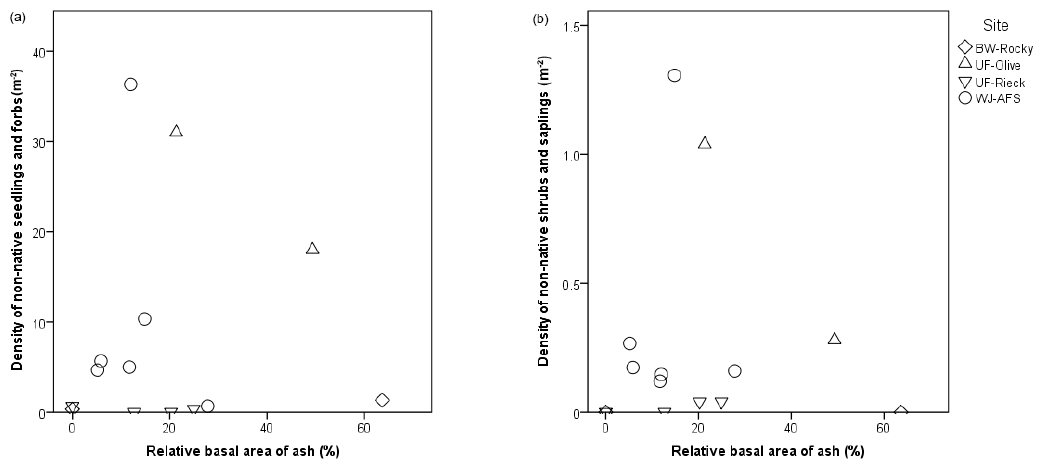
Figure 6. Effects of relative Fraxinus basal area on density of non-native vegetation, including ( a ) woody seedlings and forbs in 2017 ( r 2 = 0.003, p = 0.843) and ( b ) shrubs and saplings ( r 2 = 0.001, p = 0.955) in 2017.